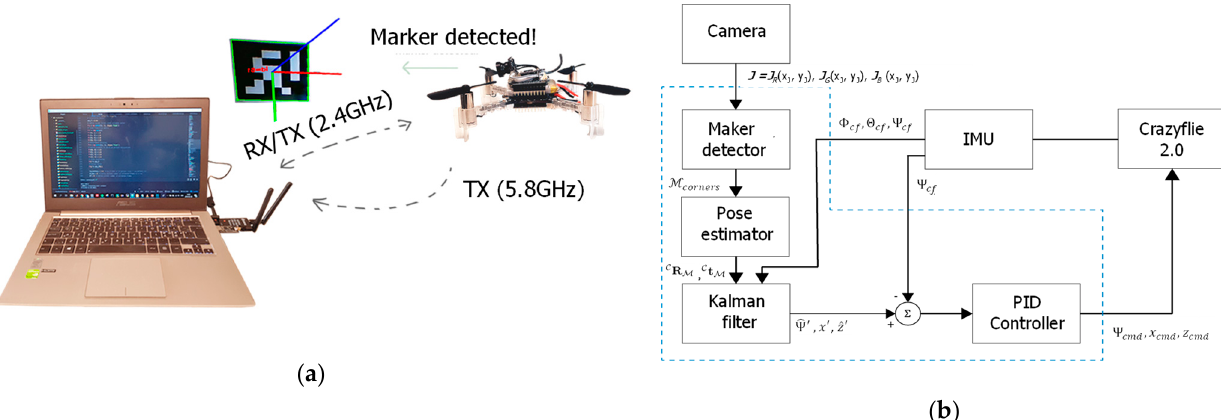
Figure 2. ( a ) Overview of the proposed off-board vision-based control system; ( b ) schematic diagram for the vision-based control of the MAV.